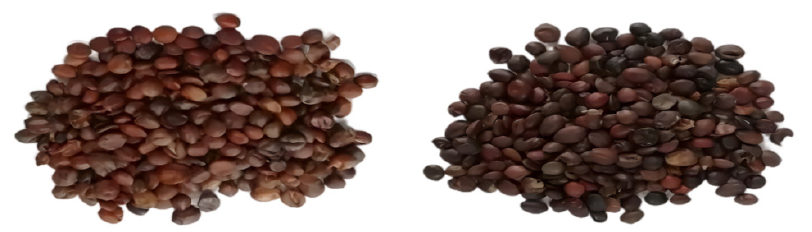
Figure 1. The normal ( left ) and rancid ( right ) ZSS samples.